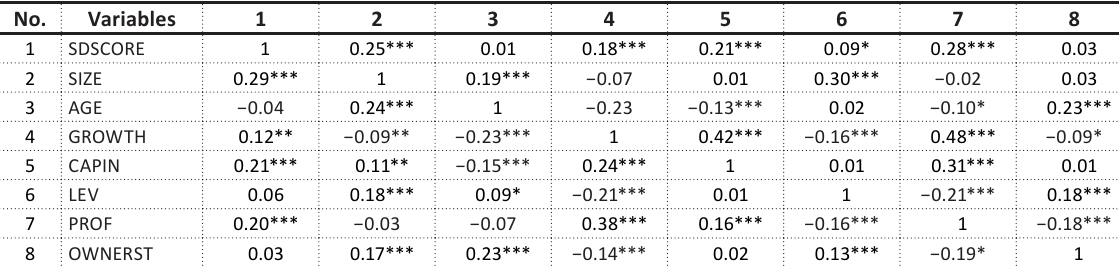
Table 3. Pearson and spearman correlation